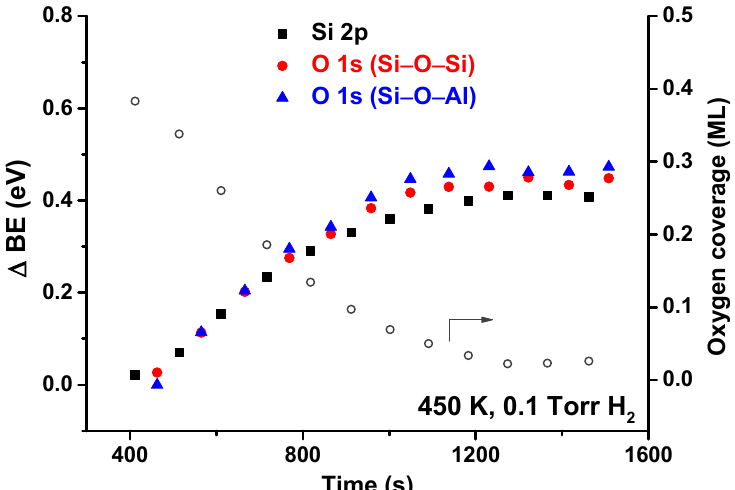
Figure 3. Si 2p ( a ) and O 1s ( b ) core level spectra before and after reaction at 450 K in 0.1 Torr of H 2 ; ( c ) deconvolution of the O 1s core level spectrum before reaction.